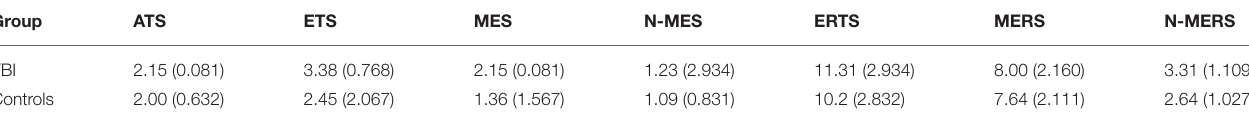
TABLE 3 | Actor studio: mean scores. Group ATS ETS MES